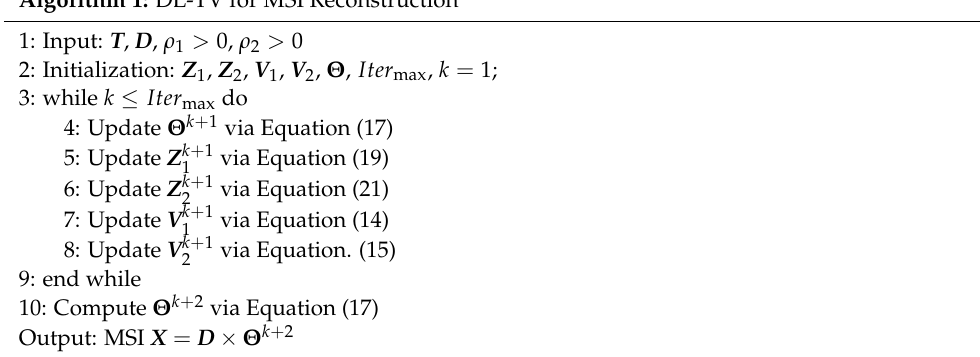
Algorithm 1: DL-TV for MSI